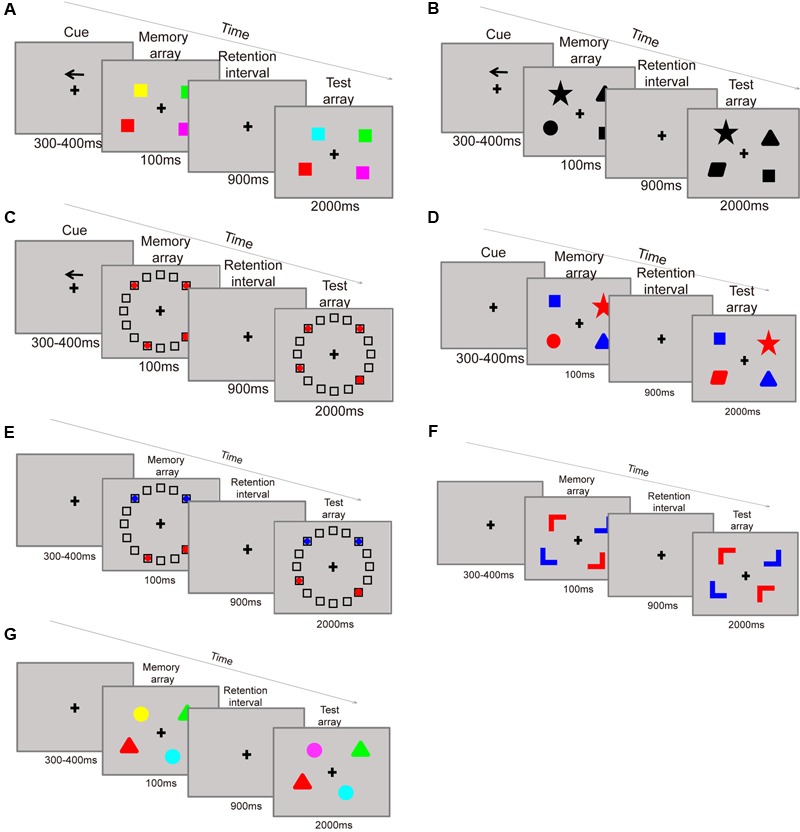
Training paradigms: remember the color on the cue side (A). Remember the shape on the cue side (B). Remember the location of items on the cue side (C). Remember the shape of the red items (D). Remember the location of the red items (E). Remember the color of triangles (G).